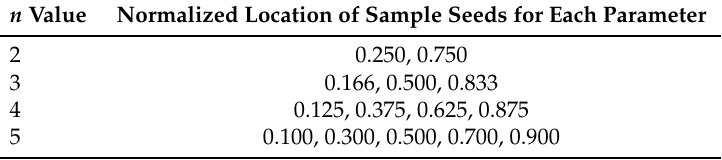
Table 3. Illustration of grid sampling determined by n for each CST